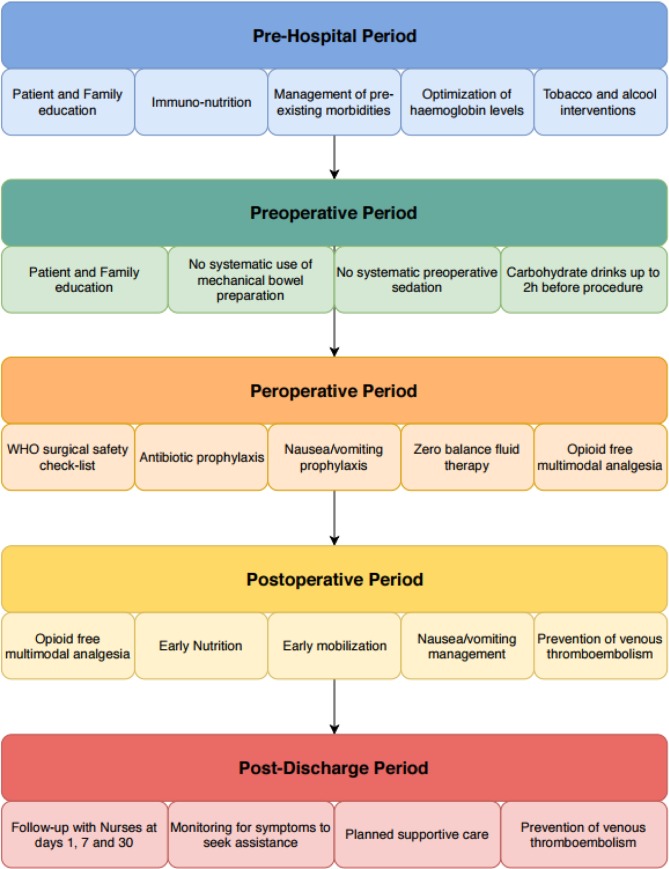
Summary of the Institut Paoli-Calmettes enhanced recovery program.